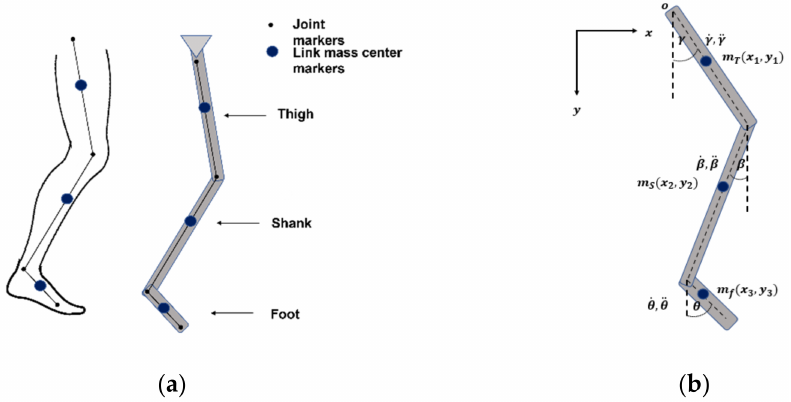
Figure 3. Figures for representation of ( a ) links, joints, and centers of mass for the leg segments and ( b ) corresponding free body